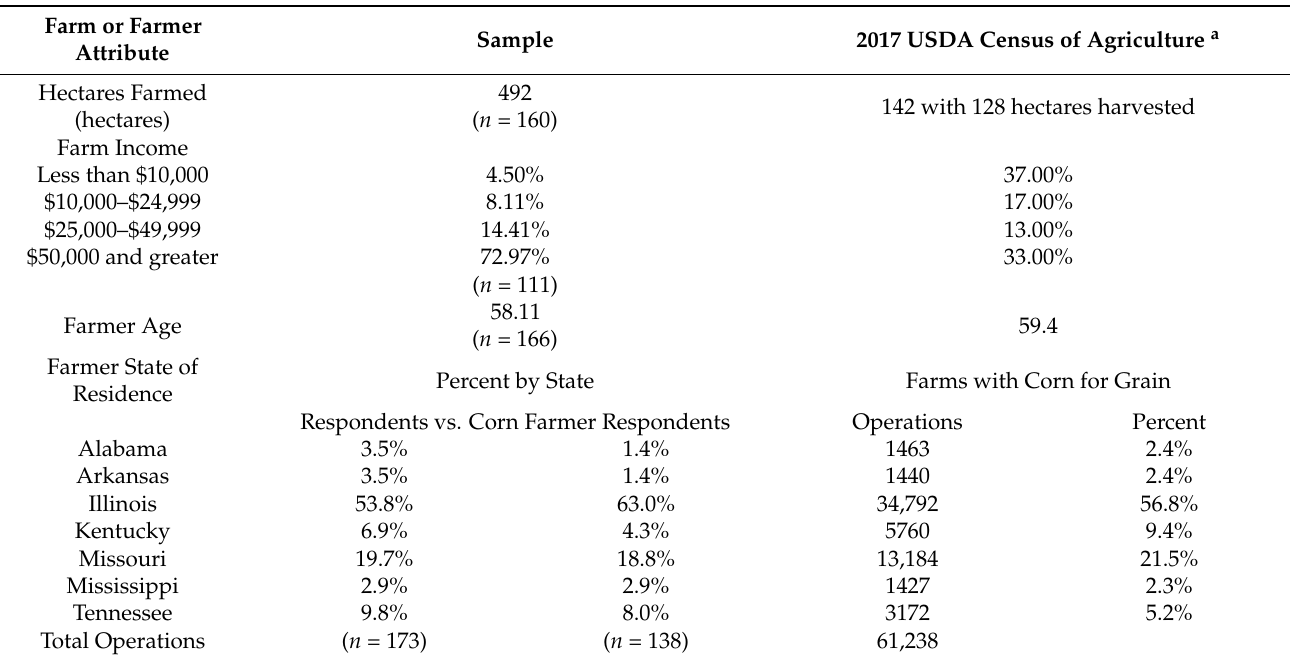
Figure 2. Interest in growing pennycress ( A ) and willingness to grow pennycress at specified farmgate prices survey questions ( B ). Table 1. Sample farm and farmer attributes of the responding row crop farmers surveyed in seven US states compared with US Department of Agriculture Census of